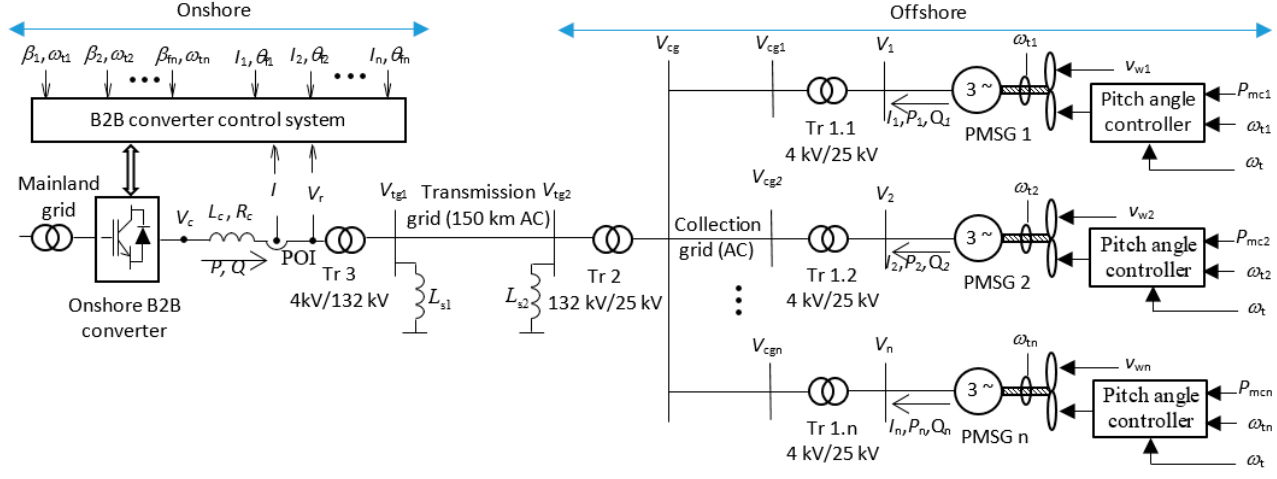
Figure 1. Schematic diagram of PCOWTG.